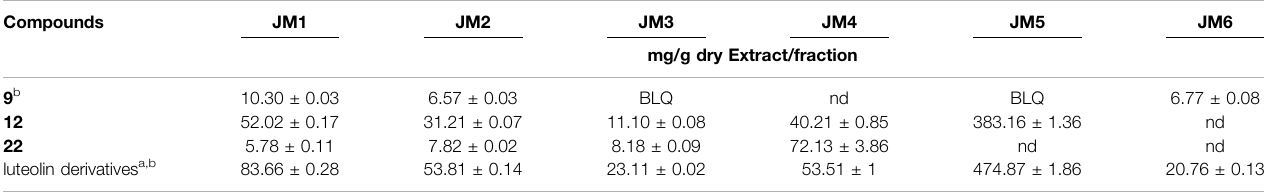
TABLE 1 | Quanti fi cation of major compounds (compounds 9 , 12 and 22 ) in J. montana extracts ( JM1 – JM3 ) and fractions ( JM4 – JM6 ) by HPLC – PDA. Compounds